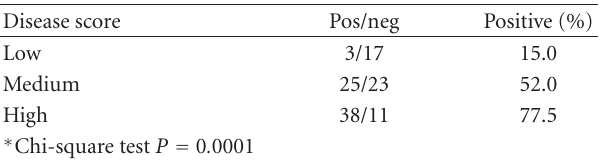
Table 3: Prevalence of S. aureus isolates in children with AD ac- cording to disease severity.